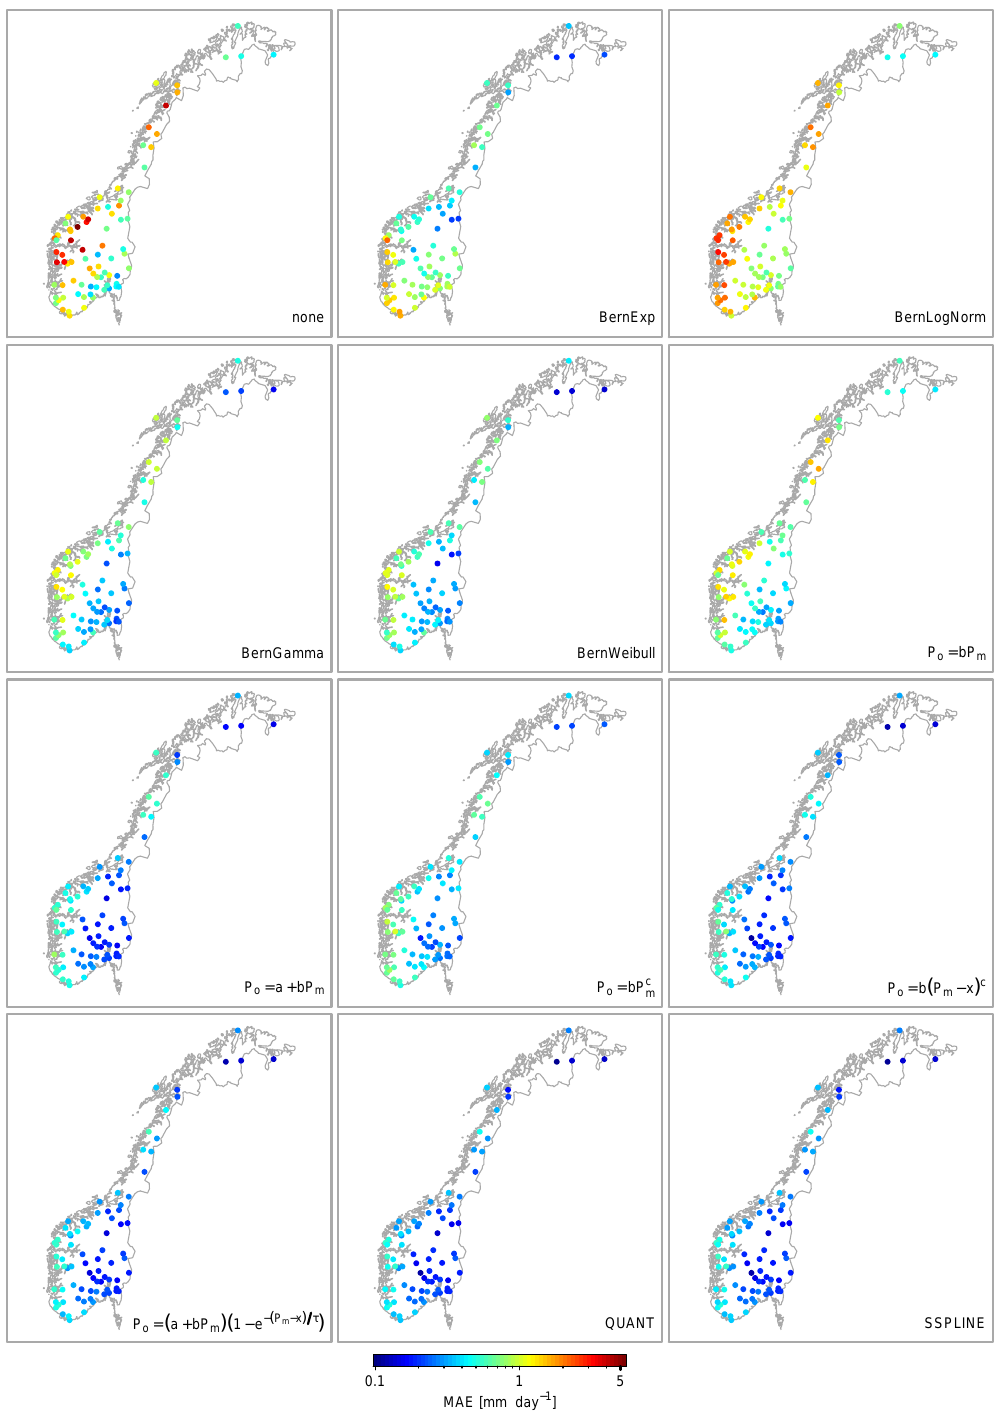
Fig. 2. Mean absolute error (MAE) between the observed and modelled empirical CDF for different statistical transformations, estimated using 10-fold cross-validation for the 1960–2000 time interval. “none” indicates uncorrected modelled values. Distribution derived transfor- mations are based on the Bernoulli-Exponential (BernExp), the Bernoulli-Log-normal (BernLogNorm), the Bernoulli-Gamma (BernGamma) and the Bernoulli-Weibull (BernWeibull) distributions. Equations: parametric transformations. QUANT: statistical transformations based on empirical quantiles. SSPLINE: statistical transformation using a smoothing